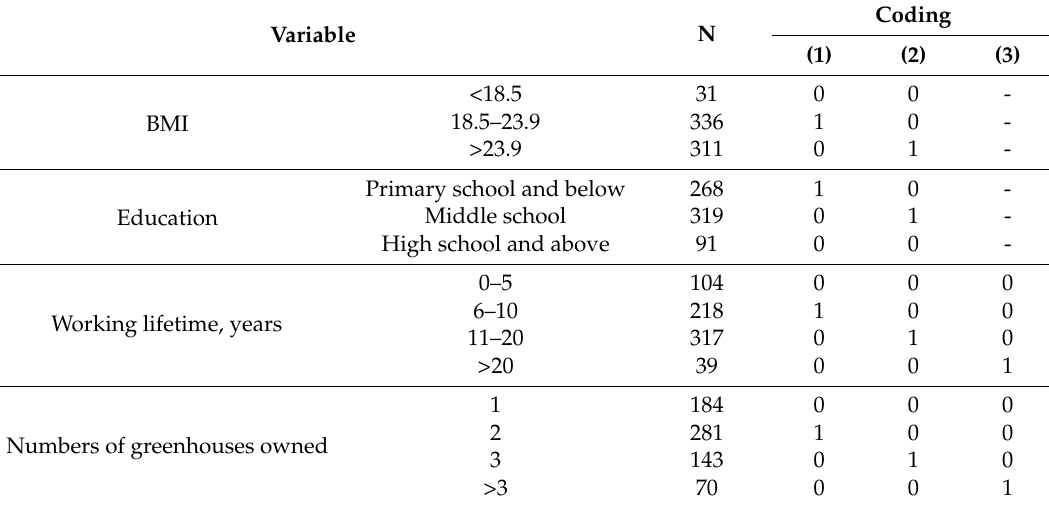
Table A3. Dummy variable contrast coding for logistic